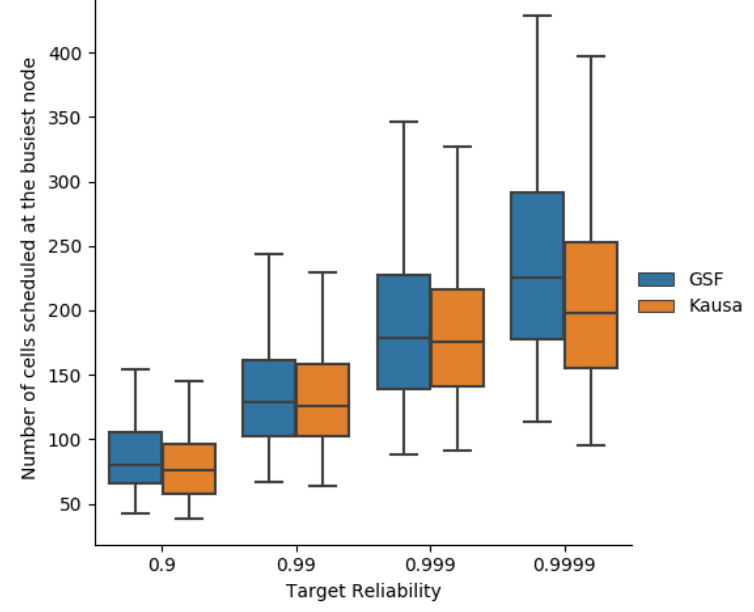
Figure 19. Number of cells used at the busiest node with MOpt and Kausa